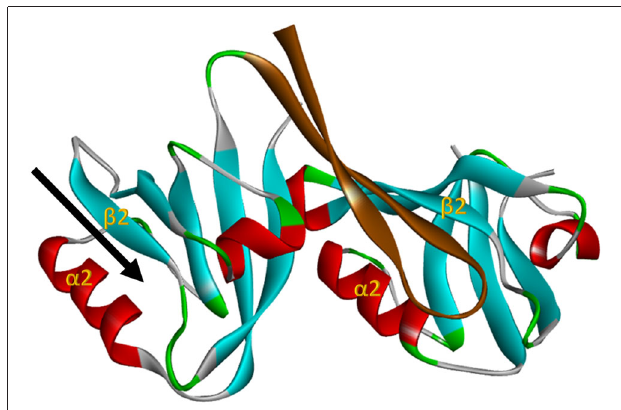
FIGURE 2 | The nNOS:PSD95 interaction. Projection of crystal structure 1QAV.pdb (Hillier et al., 1999) of the nNOS extended PDZ domain (left) docking with a classI PDZ domain (right, from syntrophin in this case). The parallel β -sheet 2/ α -helix 2 regions that form the ligand binding pockets of the PDZ domains are labelled in each domain. The β finger of the nNOS extended PDZ that docks in the classI PDZ domain is shown in brown, revealing that the PDZ ligand binding pocket of nNOS (arrow, left) remains unoccupied. This projection was generated with Accelrys Discovery